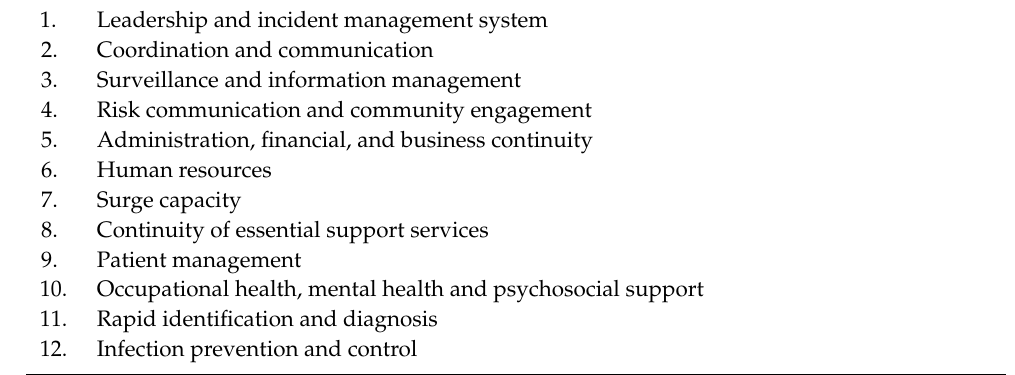
Table 1. World Health Organization (WHO) rapid hospital readiness checklist for Coronavirus 2019 (COVID-19). The checklist highlights 12 key components that are essential to managing COVID-19 in a hospital